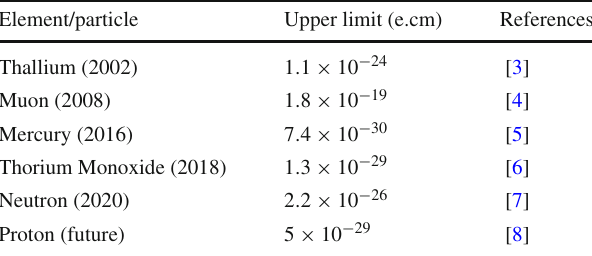
Table 2 The LHC mass limits applied here, which are motivated by the analyses in [15,16]